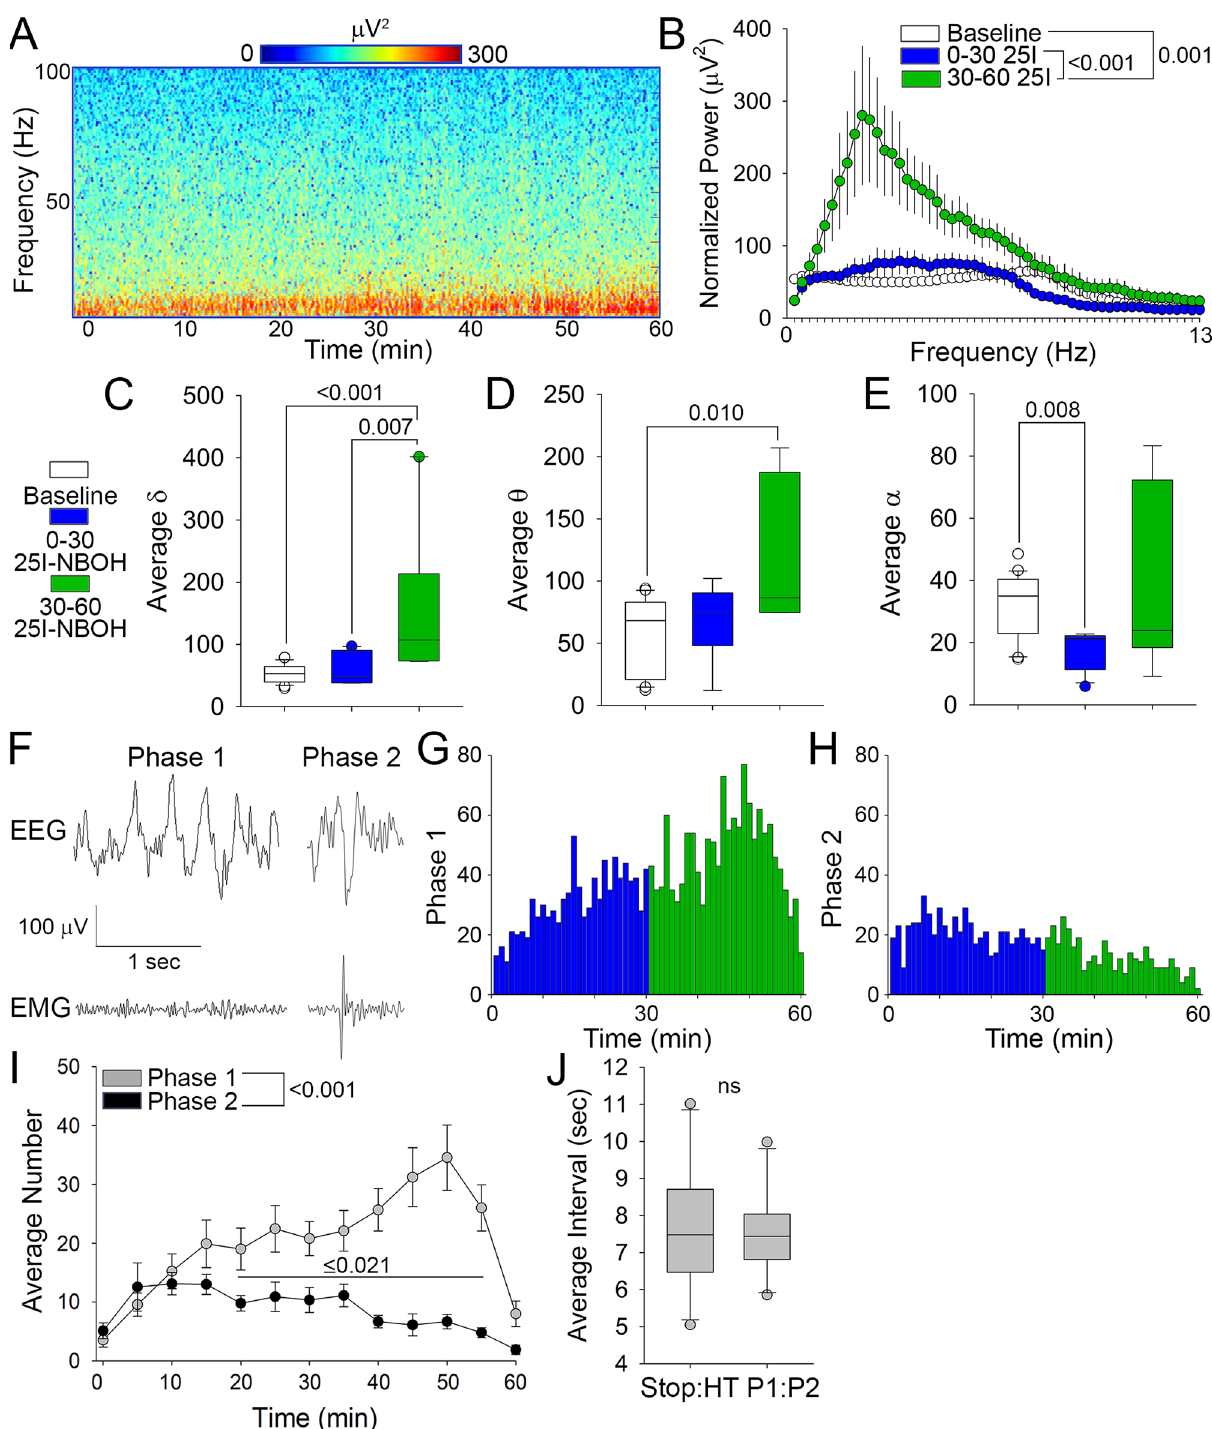
Figure 3. 25I-NBOH produces a characteristic two waveform complex that drives increased low frequency power. ( A ) Spectrogram of representative EEG recordings after administration of 25I-NBOH. ( B ) FFT of EEG recordings comparing baseline, 0–30 min, and 30–60 min after 25I-NBOH. ( C – E ) Box plot of normalized power from EEG recordings parsed into δ ( C 0.4–4.0 Hz), θ ( D 4.5–8 Hz), and α ( E 8.5–13 Hz) frequency bands. ( F ) Representative Phase 1 and Phase 2 waveforms occurring in the EEG and EMG from epoch analysis. ( G ) Plot of the cumulative Phase 1 waveforms occurring in the EEG after administration of 25I-NBOH. ( H ) Plot of the cumulative Phase 2 waveforms occurring in the EEG after administration of 25I-NBOH. ( I ) Average number of Phase 1 and Phase 2 waveforms. ( J ) Box plot comparing the time interval between a stop and head-twitch observed in the open field and the interval between Phase 1 and Phase 2 waveforms in the EEG recordings (ns). Details of the experimental design and statistical analyses, including numbers of animals, mean ± SE, main effects and p values, can be found in Sup. Table